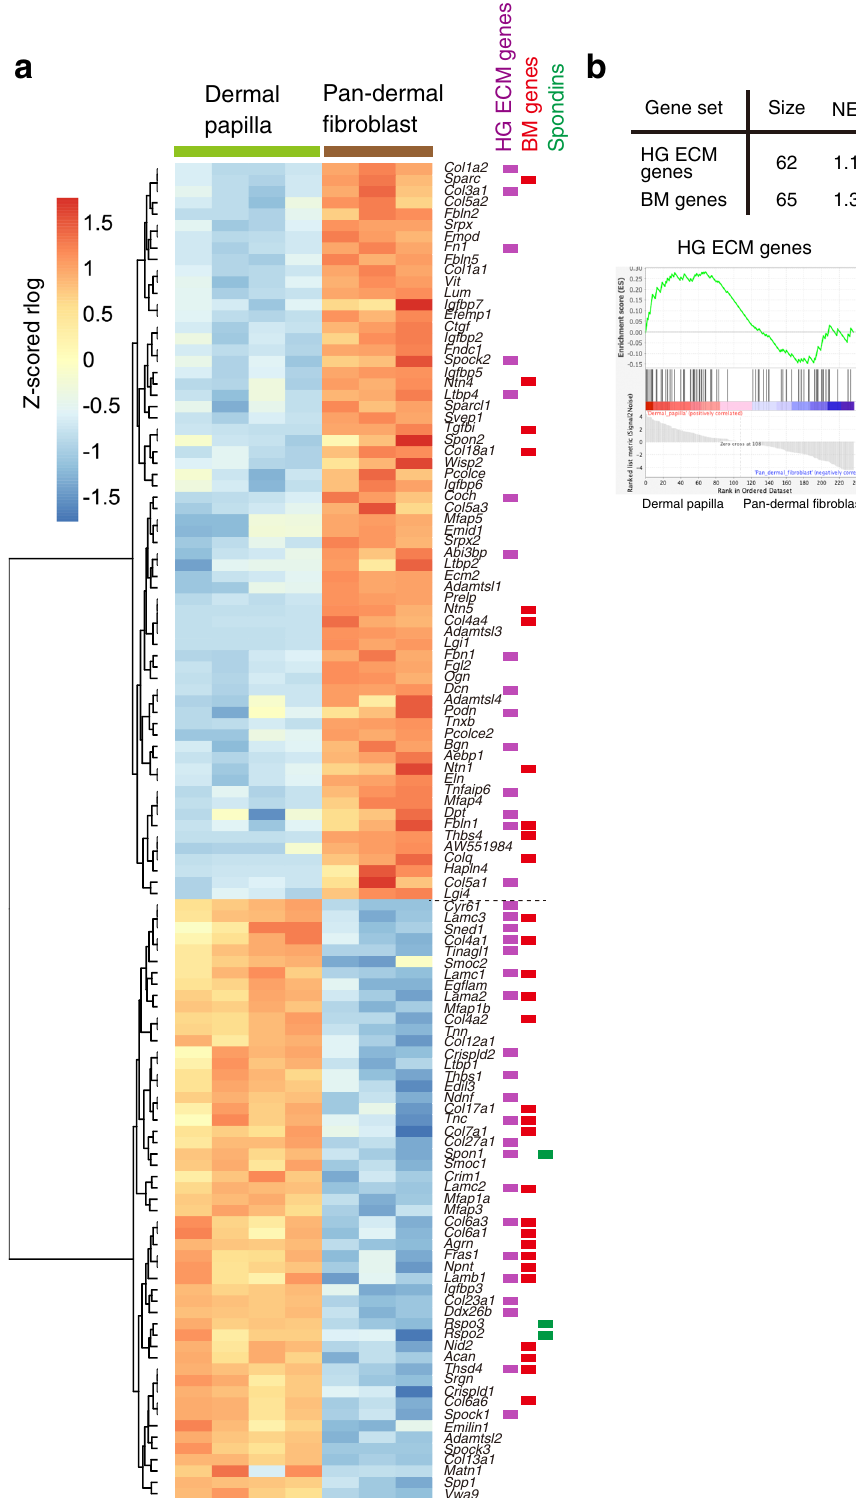
HG and DP cells, while also reportedly being involved in HF morphogenesis 23 . Therefore, we examined the effects of lama5 gene deletion on HF regeneration. To investigate the cellular origin of laminin α 5, Lama5 fl oxed mice were crossed with Keratin 5-Cre mice, which speci fi cally express Cre in basal epi- thelium. In the mutant, laminin α 5 immunoreactivity